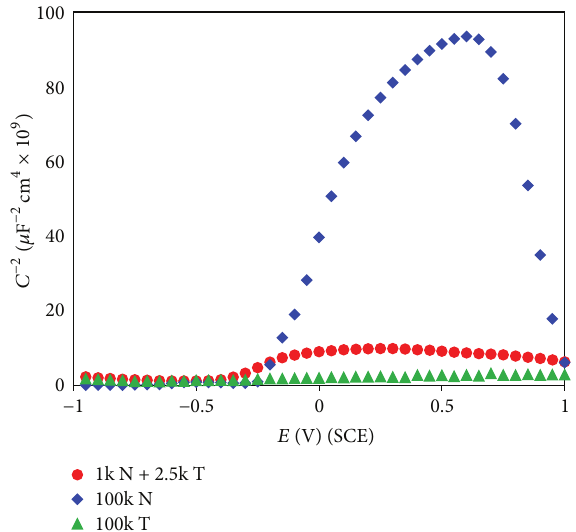
Figure 11: Effect of corrosion inhibitors (N: ppm NO 2− , T: ppm TEA) on Mott-Schottky plot for the passive film formed at 0V (SCE) in deaerated tap water at 25 ∘ C.